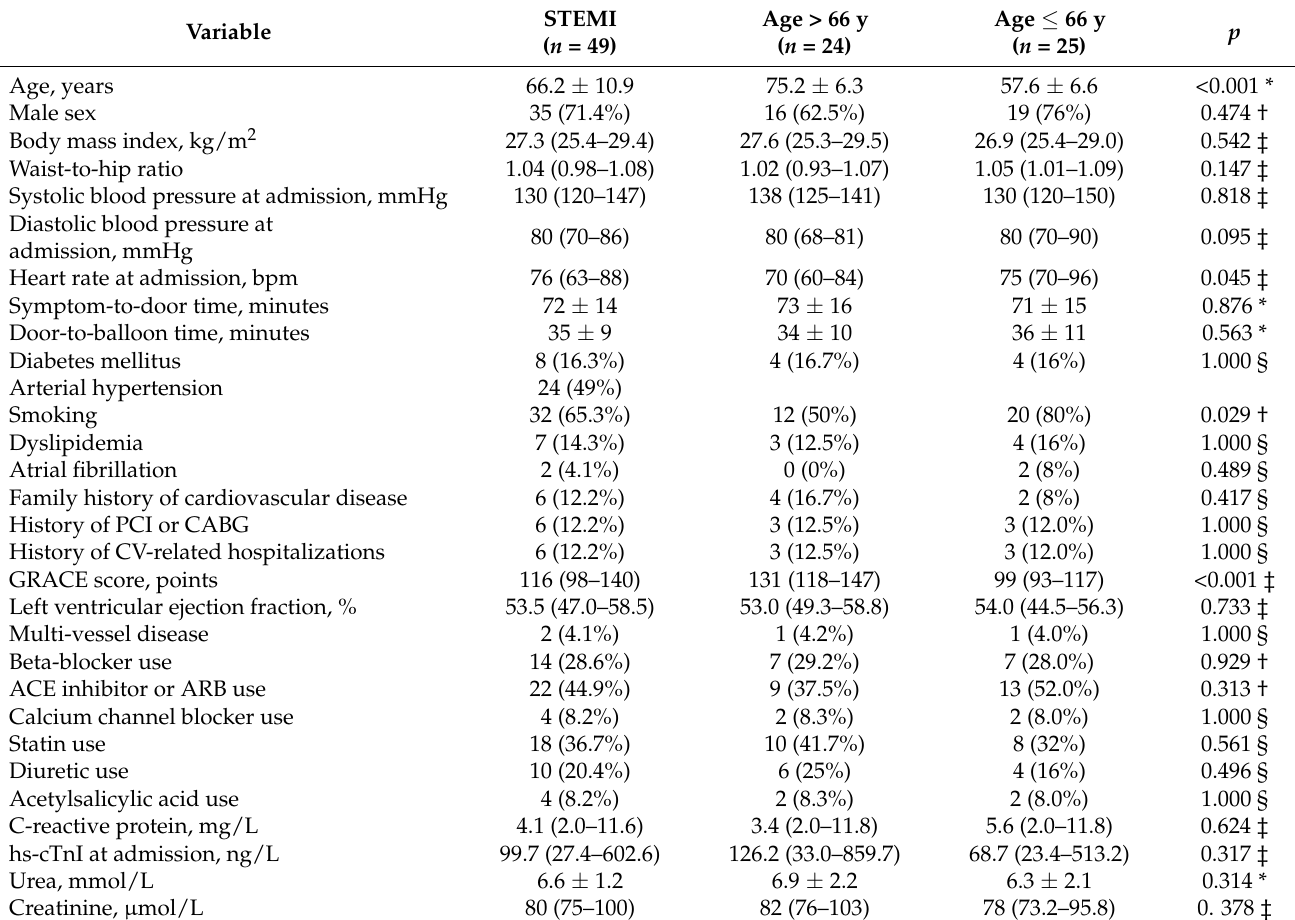
Table 1. Baseline characteristics of